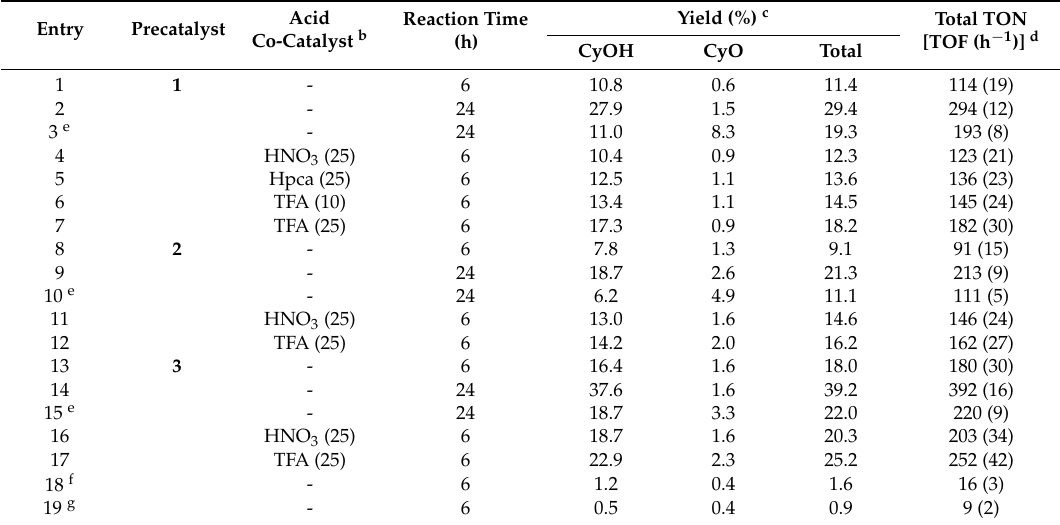
Table 4. Total yield (cyclohexanol and cyclohexanone) with time in the oxidation of cyclohexane